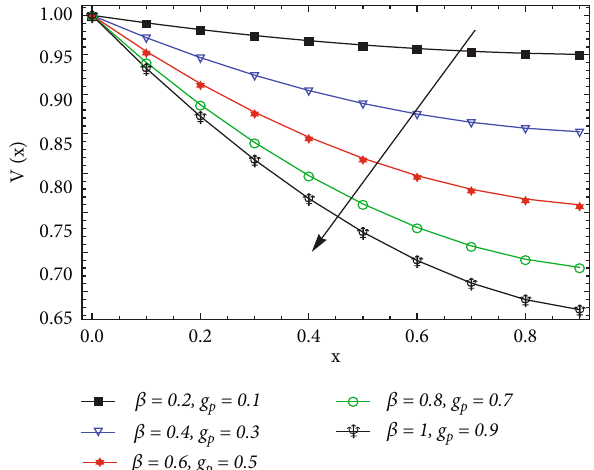
on V ð x Þ where α = 0 : 95and p